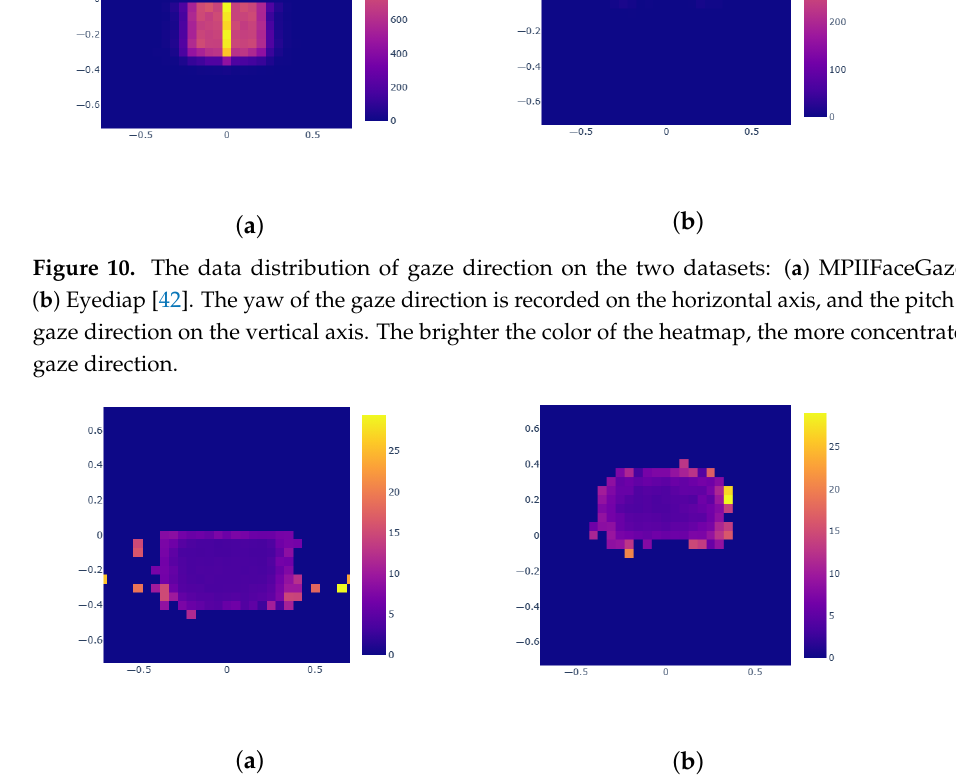
Figure 11. The angular error distribution of the STTDN on two datasets: ( a ) MPIIFaceGaze [20]; ( b ) Eyediap [42]. The yaw of the gaze direction is recorded on the horizontal axis, and the pitch of the gaze direction on the vertical axis. The brighter the color of the heatmap, the bigger the angular